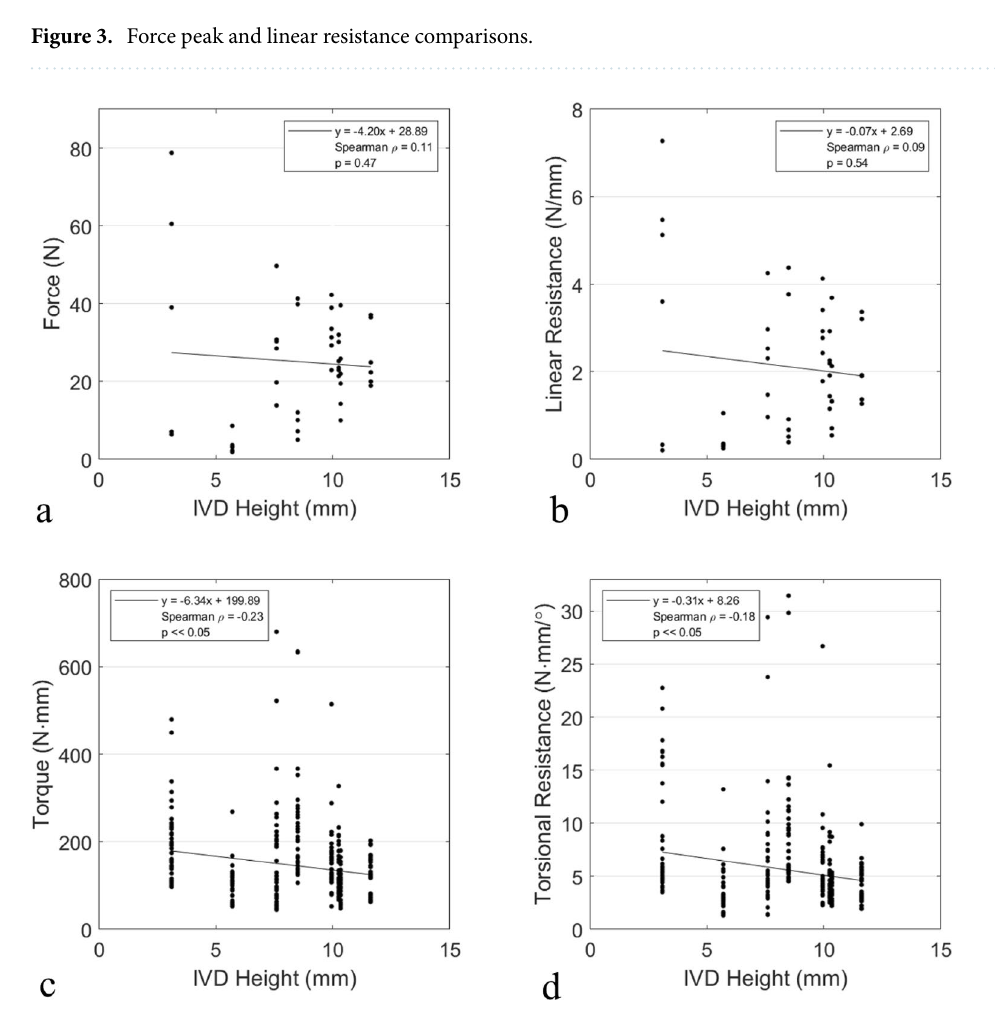
Figure 4. Linear ( a , b ) and torsional ( c , d ) peak and resistance values as correlated to intervertebral disc (IVD)